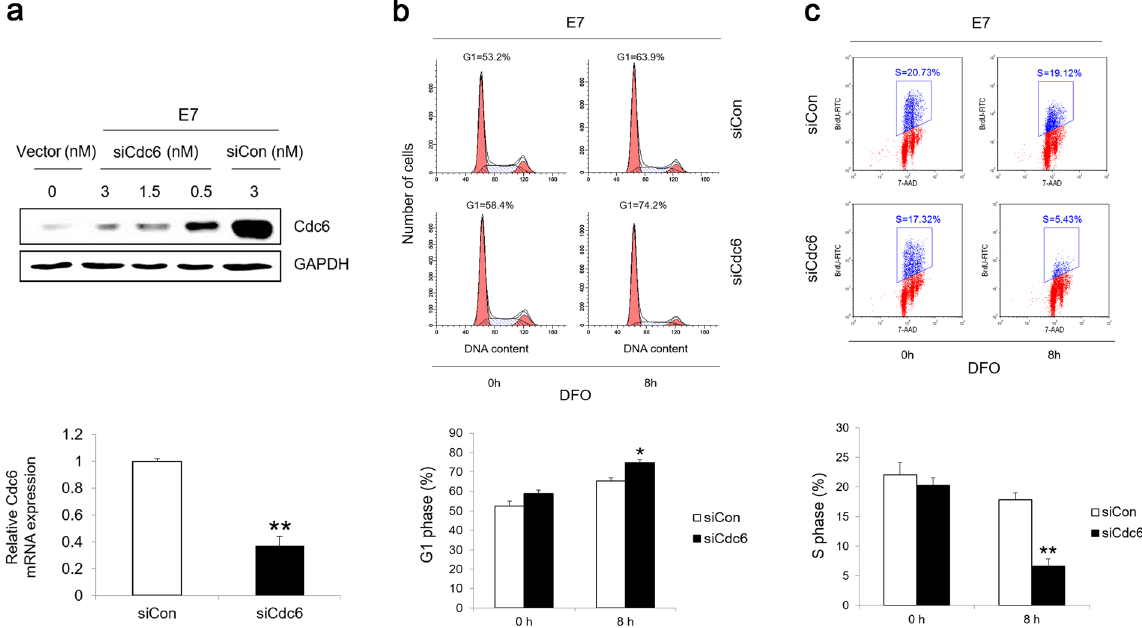
Figure 5. Cdc6 is important for E7 expressing cells to alleviate G1 arrest under hypoxia. ( a ) Cdc6 in RPE1 E7 cells was knocked down by siRNA at indicated doses and analyzed by immunoblotting (Upper panel) (original blots are presented in Supplementary Figure 3) and RT-qPCR (Lower panel, 3 nM siRNA was used). ( b ) RPE1 E7 cells were transfected with either Cdc6 or negative control siRNA. Cells were treated with 200 μ M DFO 24 hours post-transfection and cultured for an additional 8 hours, stained with PI and analyzed by flow cytometry. A representative experiment of 3 is shown (Upper panel) and summarized (Lower panel). ( c ) RPE1 E7 cells were transfected with either Cdc6 or negative control siRNA. Twenty-four hours later, cells were treated with 200 μ M DFO for 6 hours and then labeled with BrdU for 2 additional hours. Cells were stained with anti-BrdU antibody, counterstained with 7-AAD, analyzed by flow cytometry. Data from a representative of 3 experiments are shown (Upper panel). Data are summarized (Lower panel). Error bars reflected the standard error of the mean. * P < 0.05; ** P <